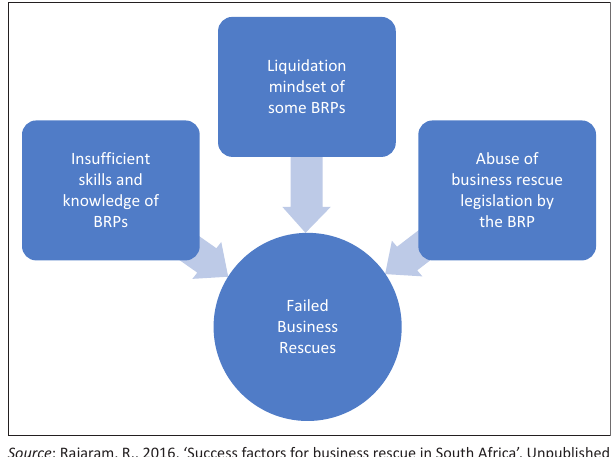
FIGURE 2: Business rescue practitioners’ role in failed business